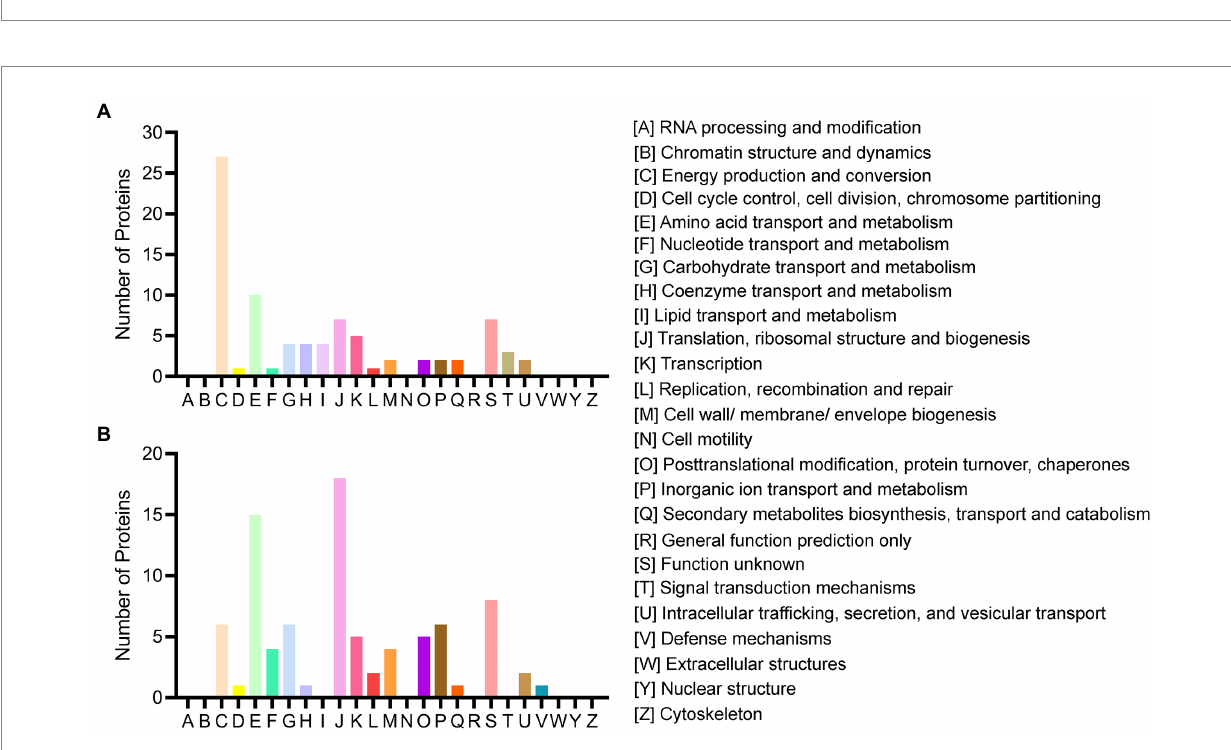
FIGURE 2 COG functional classification of the DEPs in B. pumilus (B18 vs. B40) (A) and K. vulgare (K18 vs. K40) (B)